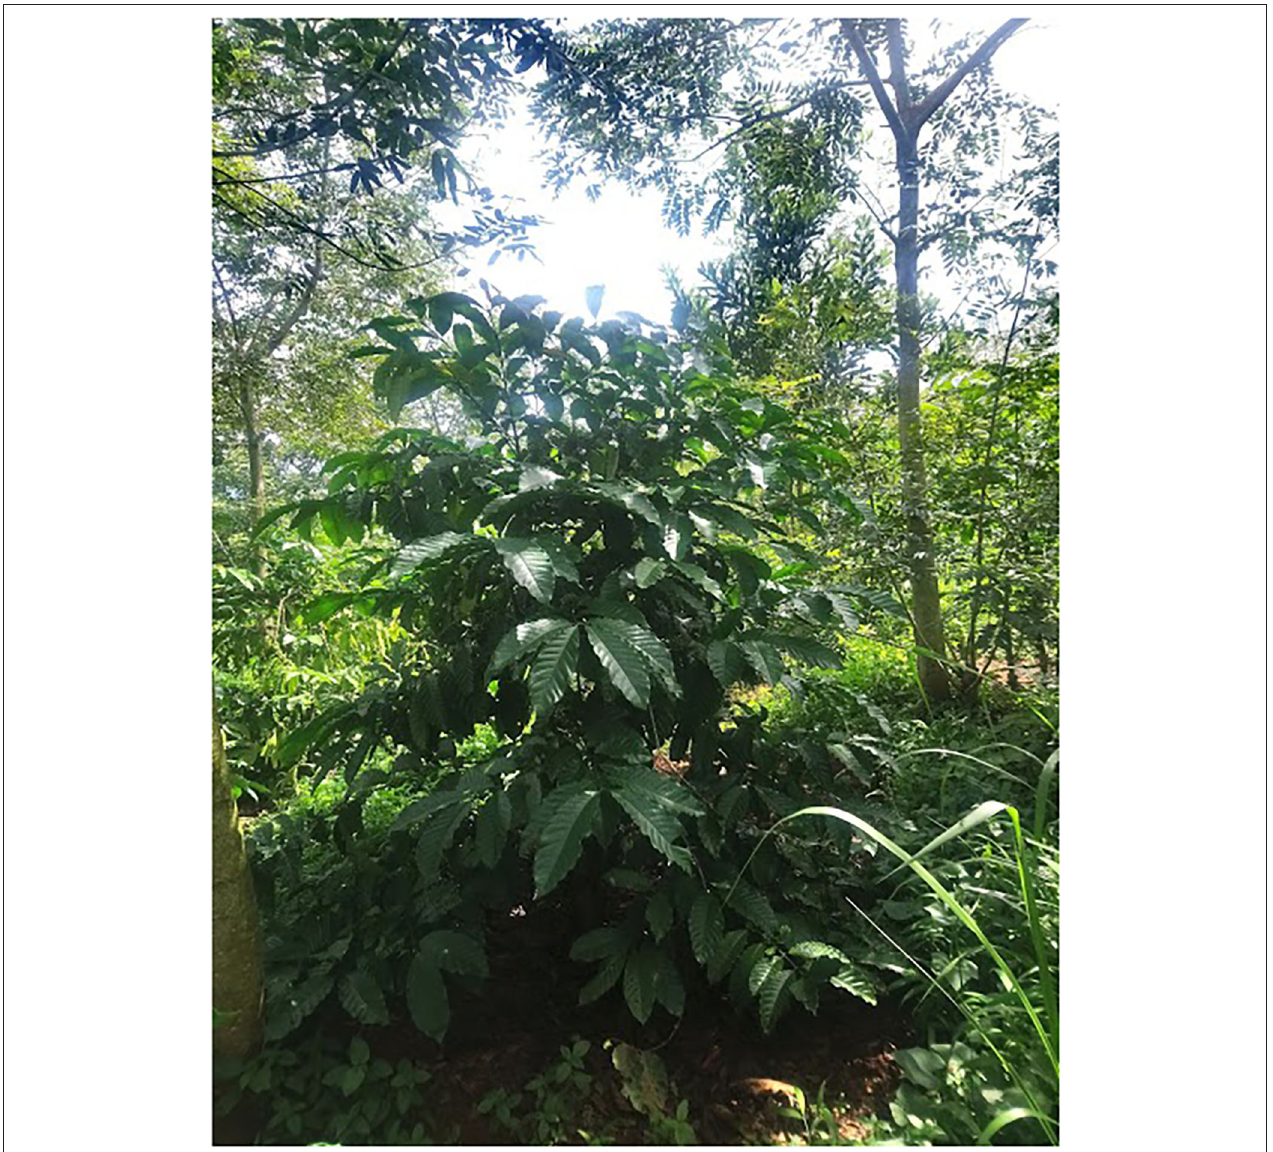
FIGURE 4 | Shade farm—Coffee- Senna Siamea intercropping. Source: Photo provided by the owner of the shade farm.